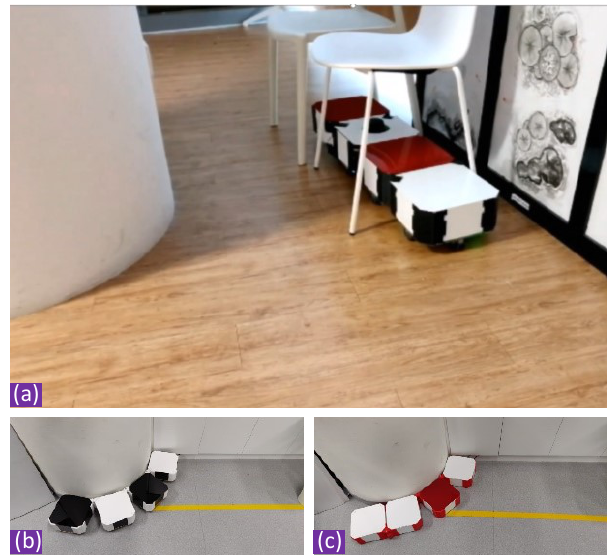
Figure 2. Floor cleaning robotic platform hTetro ( a ) accessing narrow passages ( b ) hTetro-LLL across circular section, and ( c ) hTetro-LLR across circular